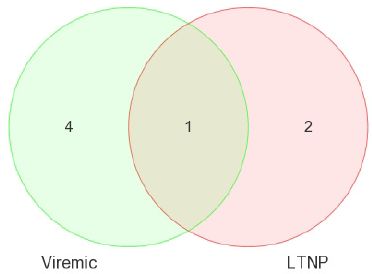
indicates downregulation in disease state compared to negative. Positive fold change indicates upregulation in disease state compared to negative.